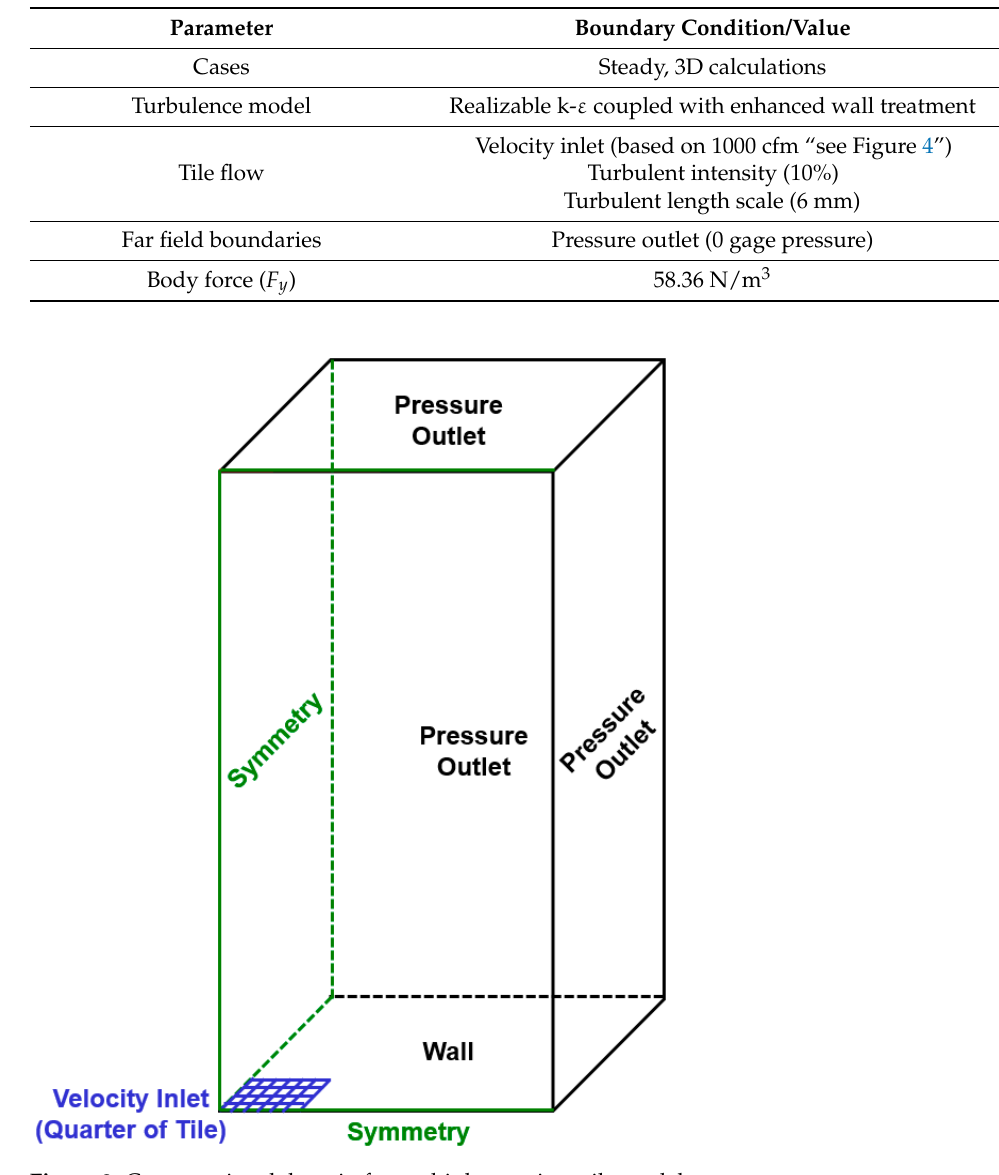
Table 1. CFD model boundary conditions and specifications.